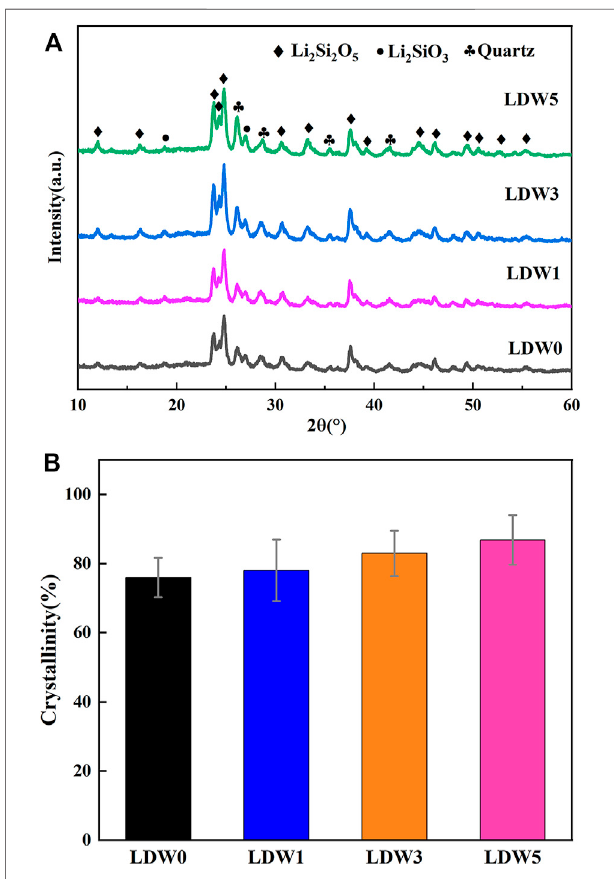
FIGURE 2 | (A) XRD patterns and (B) crystallinity of the Li 2 Si 2 O 5 glass- ceramics with different